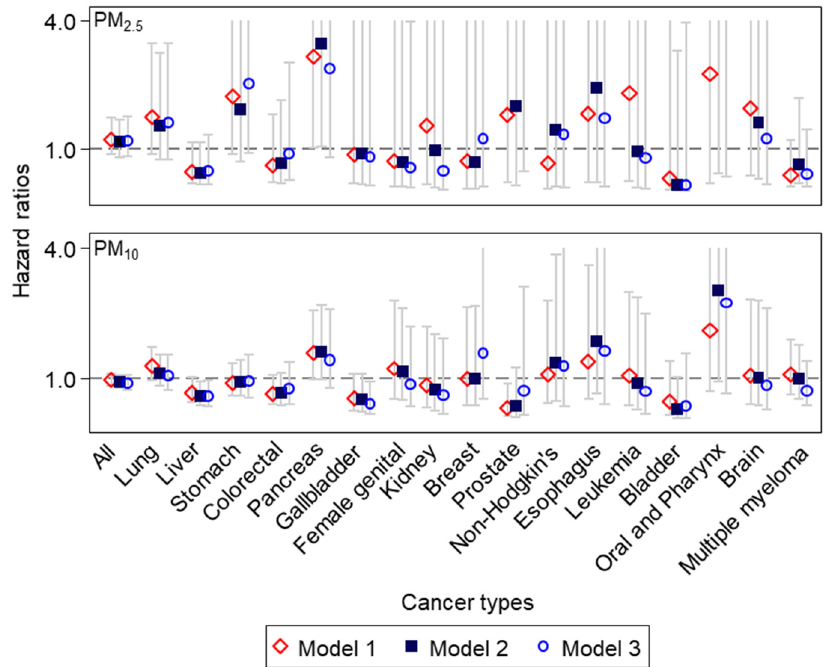
Figure 2. Hazard ratios and 95% confidence intervals of cancer-specific mortality for a 10 µ g/m 3 increase in individual-level PM concentrations for the previous 5 years, after adjusting for individual or areal characteristics in 87,608 National Health Insurance Service–National Sample Cohort subjects in the Seoul Metropolitan Area (cancer types seen from the highest number of deaths on the left to the lowest on the right; the maximum y–axis limit set to 4.0, for improving readability without presenting extremely high upper bounds of confidence intervals, as seen in Tables S3 and S4).